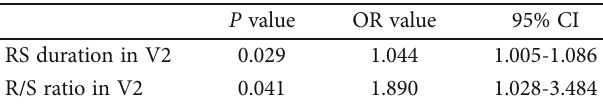
Table 4: Multivariate analysis of variables in prediction of failed ablation of